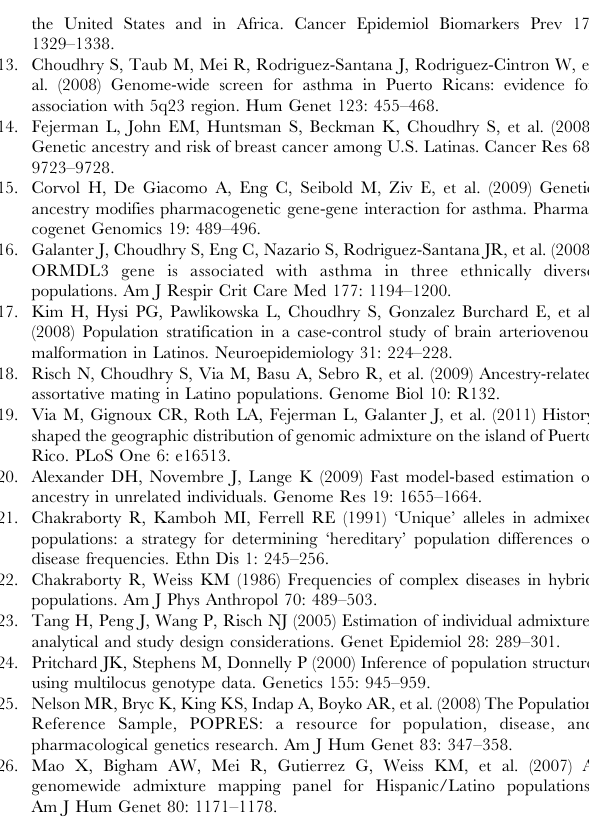
Figure S1 Map of Federal District and first, second and third belt. (TIF) Figure S2 1 st and 2 nd Multidimensional components of samples from Buenos Aires metropolitan area and ancestral individuals (black triangles). Samples from the Capital are represented in green, from the 1 st urban belt in pink, and from the 2 nd urban in orange.